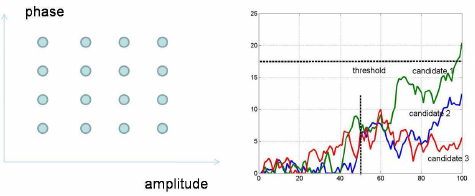
Figure 39. Illustration of parallel CUSUM